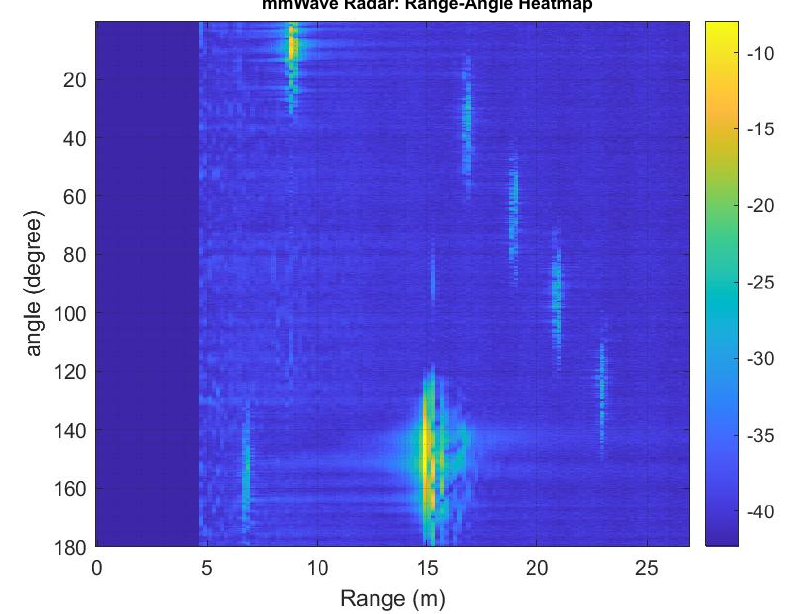
Figure 4. Range-angle map for multi-target measurement